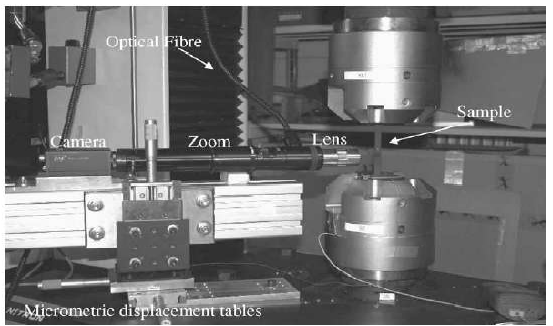
Fig. 4. Experimental set up